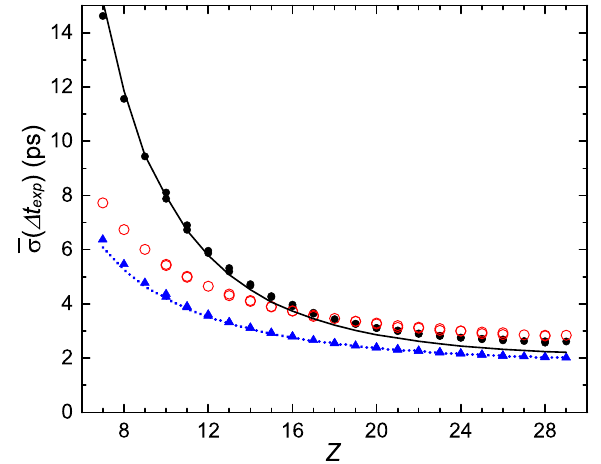
as a function of atomic exp values (black filled coi